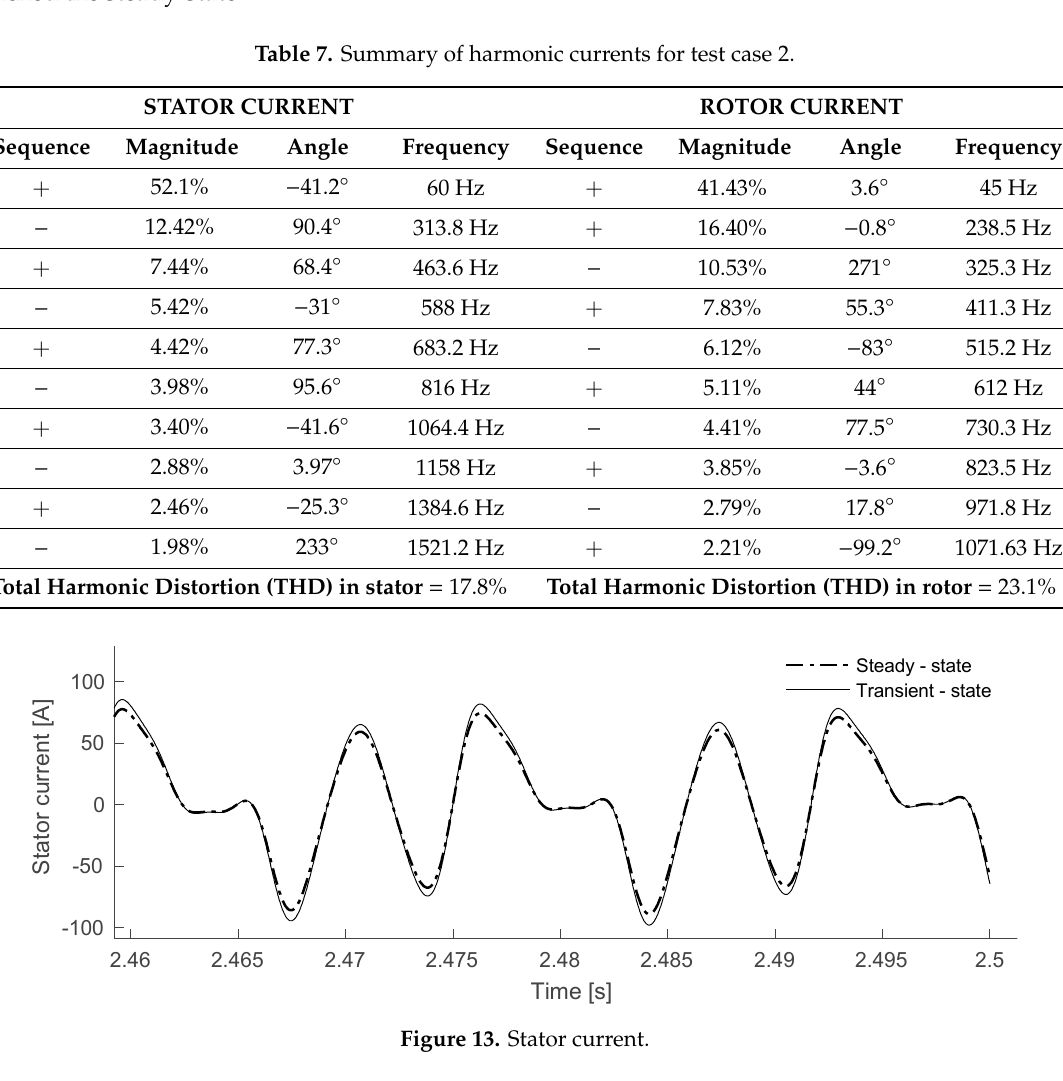
Figure 14. Rotor current. Table 7. Summary of harmonic currents for test case 2. STATOR CURRENT